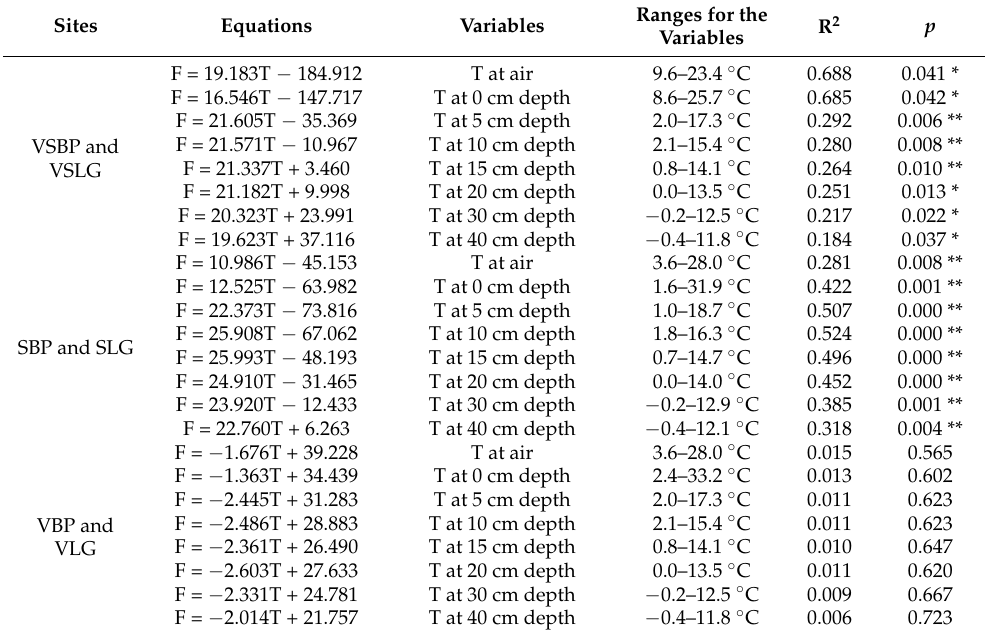
Table 1. Relationships between CO 2 fluxes and air and soil temperatures within the different vegetation types within NRWNNR.